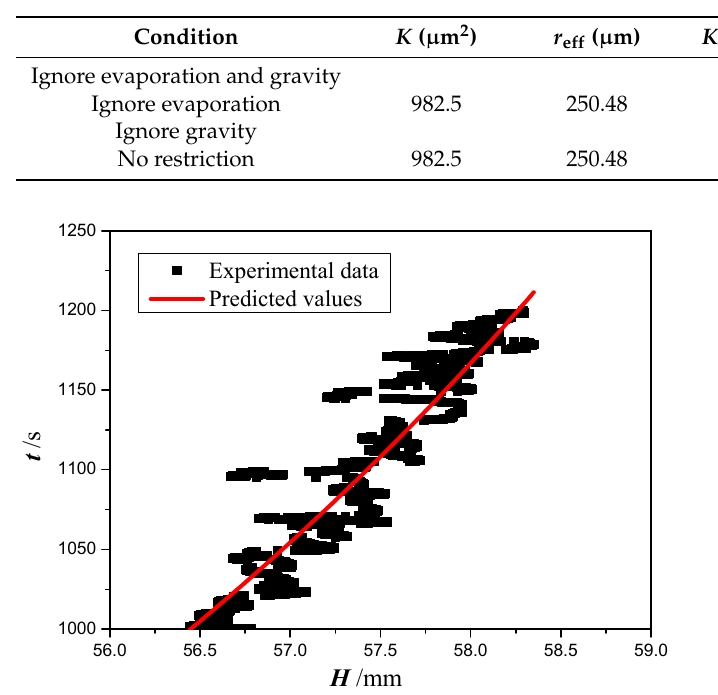
Figure 9. Comparison of time between experimental data and predicted values.